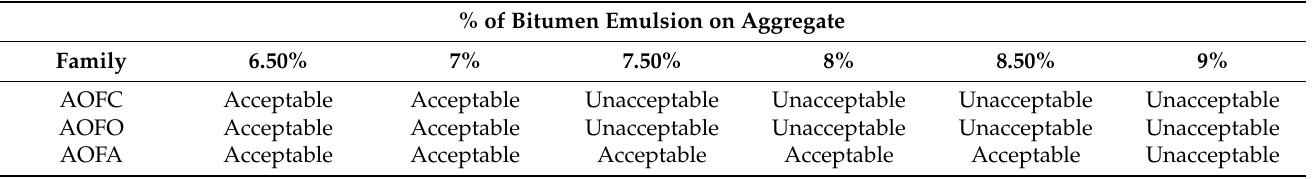
Table 8. Binder drainage test for different bituminous mixes (AOFC, AOFO, and AOFA) with increasing emulsion percentages. % of Bitumen Emulsion on Aggregate